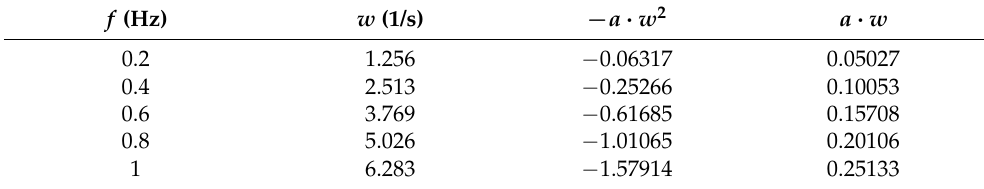
Table 8. Numerical results of pure heave motion of the underwater vehicle by our CFD method.